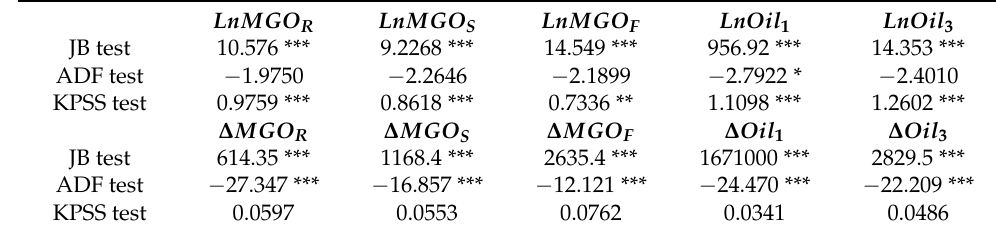
Table 2. The Stationary test and JB